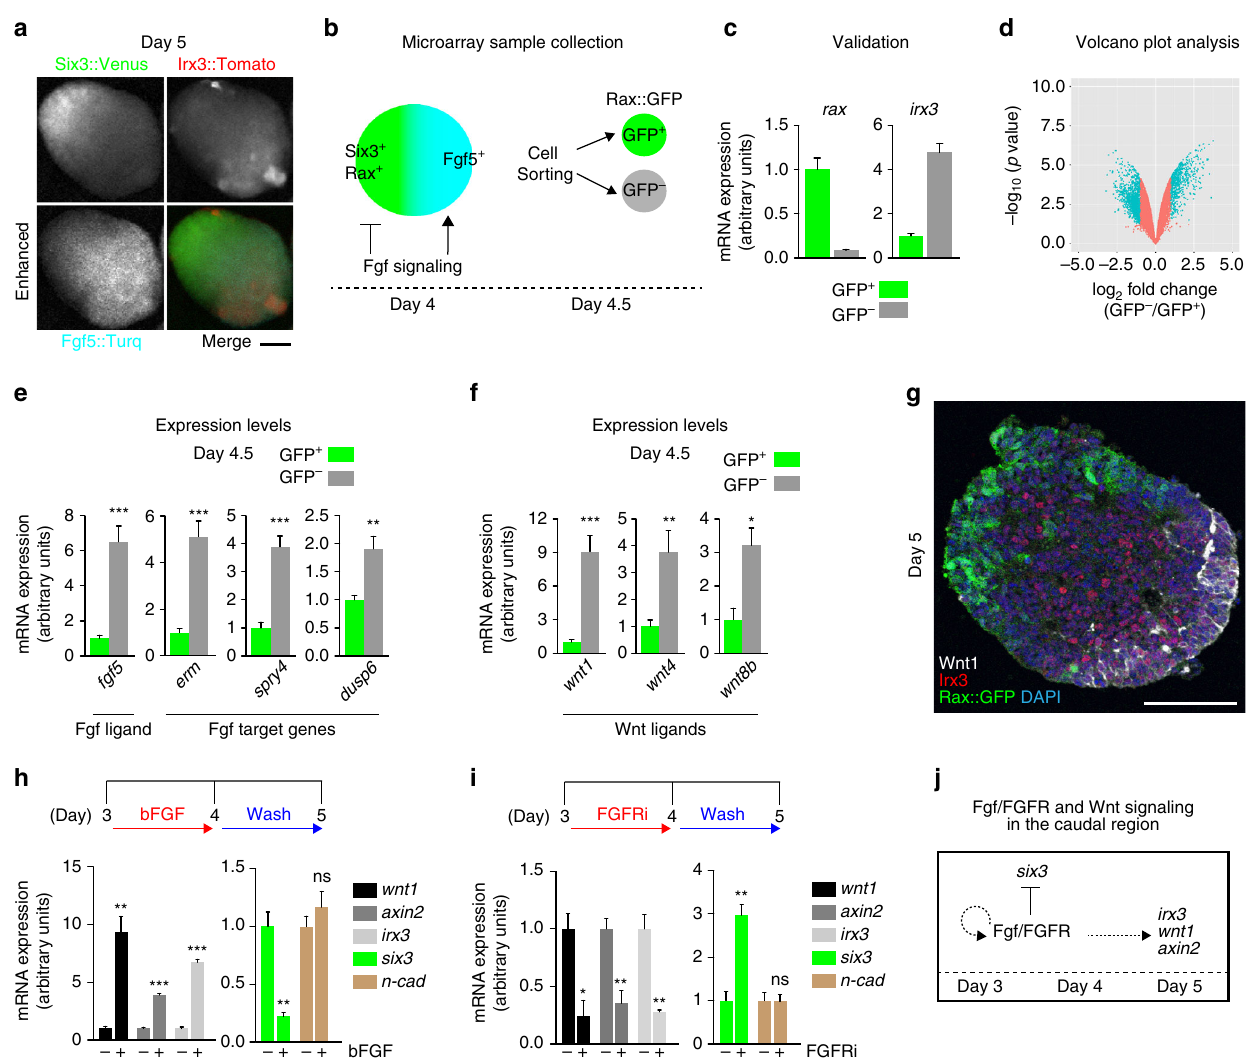
Fig. 4 Genome-wide analysis of the polarized tissue reveals differential expression of Wnt signaling components in the caudal region. a Fluorescent images of a day-5 aggregate using a Fgf5::Turq//Six3::Venus//Irx3::Tomato ESC line. Fgf5::Turq signals were enhanced by the auto contrast function of ImageJ software due to its dim expression at culture day 5. b Schematic diagram of microarray sample collection. c A validation of microarray samples via RT-qPCR, showing rax and irx3 expression in FACS-sorted GFP + and GFP − cells. d Volcano plot drawn by plotting points of all probe sets with log2 fold-changes of GFP − expression values to GFP + (X-axis) and p -values of signi fi cant differences (Y-axis). Blue dots indicate log2 fold-change of more than 1 (i.e., more than two-fold). e , f Quanti fi cation of Wnt and Fgf signaling-related-gene expressions via RT-qPCR, following FACS sorting of GFP + and GFP - cells. g Immunohistochemistry was performed on cryosections of day-5 Rax::GFP aggregates with antibodies recognizing Wnt1, Irx3 and GFP, showing Wnt1, Irx3 and Rax::GFP signals. h , i Quanti fi cation of gene expressions via RT-qPCR, following time-speci fi c treatment of bFGF and PD173074. j Schematic of Fgf/FGFR and Wnt signaling relationship in ESC-derived caudal differentiation in vitro. Error bars indicate s.e.m of each experiment ( c , e , f , h , i ). Signi fi cance was determined using unpaired t -test. * P < 0.05; ** P < 0.01; *** P < 0.001; ns, not signi fi cant ( e , f , h , i ). Scale bars, 100 µ m ( a , g